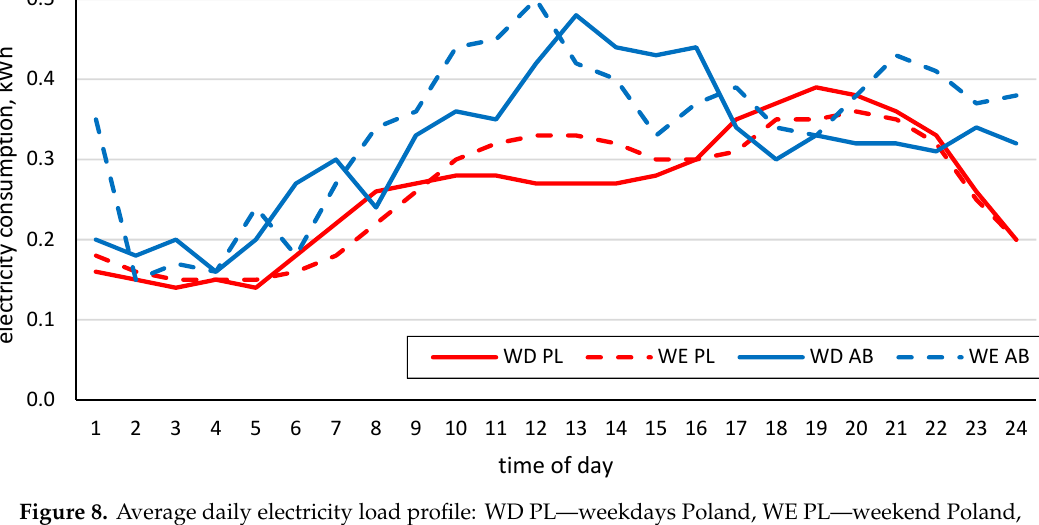
Figure 8. Average daily electricity load profile: WD PL—weekdays Poland, WE PL—weekend Poland, AB—analyzed building. Source: own study based on [59].